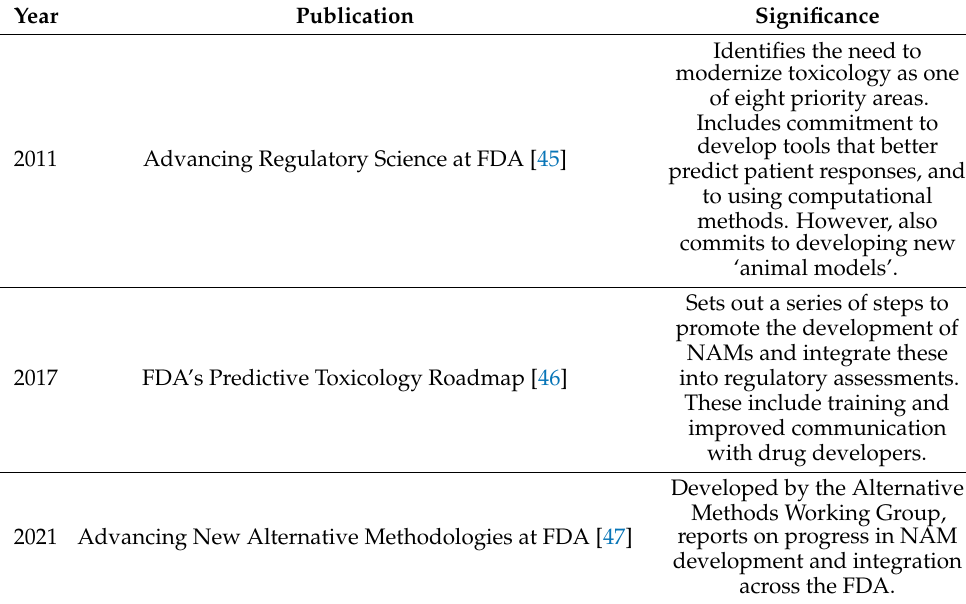
Table 1. Relevant publications by the